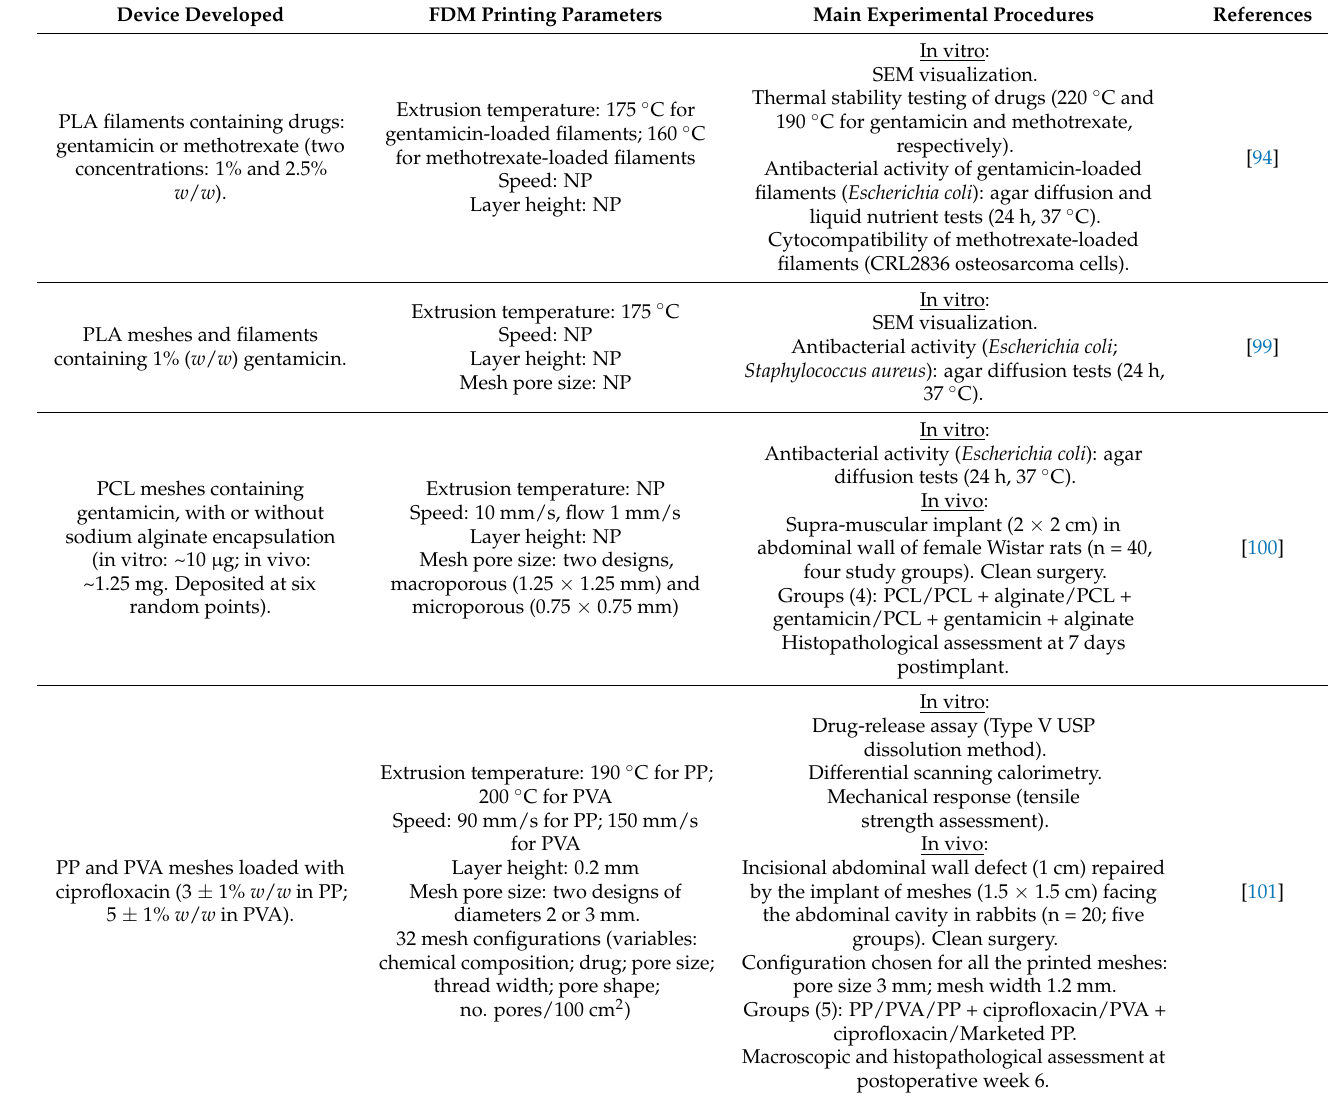
Table 2. Summary of the experimental research conducted to date to develop drug-loaded bioactive hernia repair mesh materials via additive manufacturing technology. (Abbreviations: FDM: fused deposition model; NP: not provided; PCL: polycaprolactone; PLA: polylactic acid; PP: polypropylene; PVA: polyvinyl alcohol; SEM: scanning electron microscopy). Device Developed FDM Printing Parameters Main Experimental